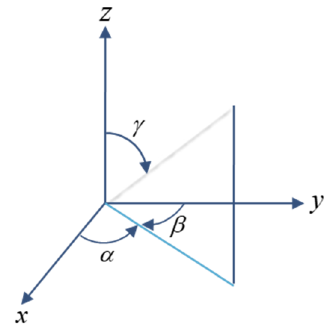
Figure 1. Definition of Fiber Orientation.